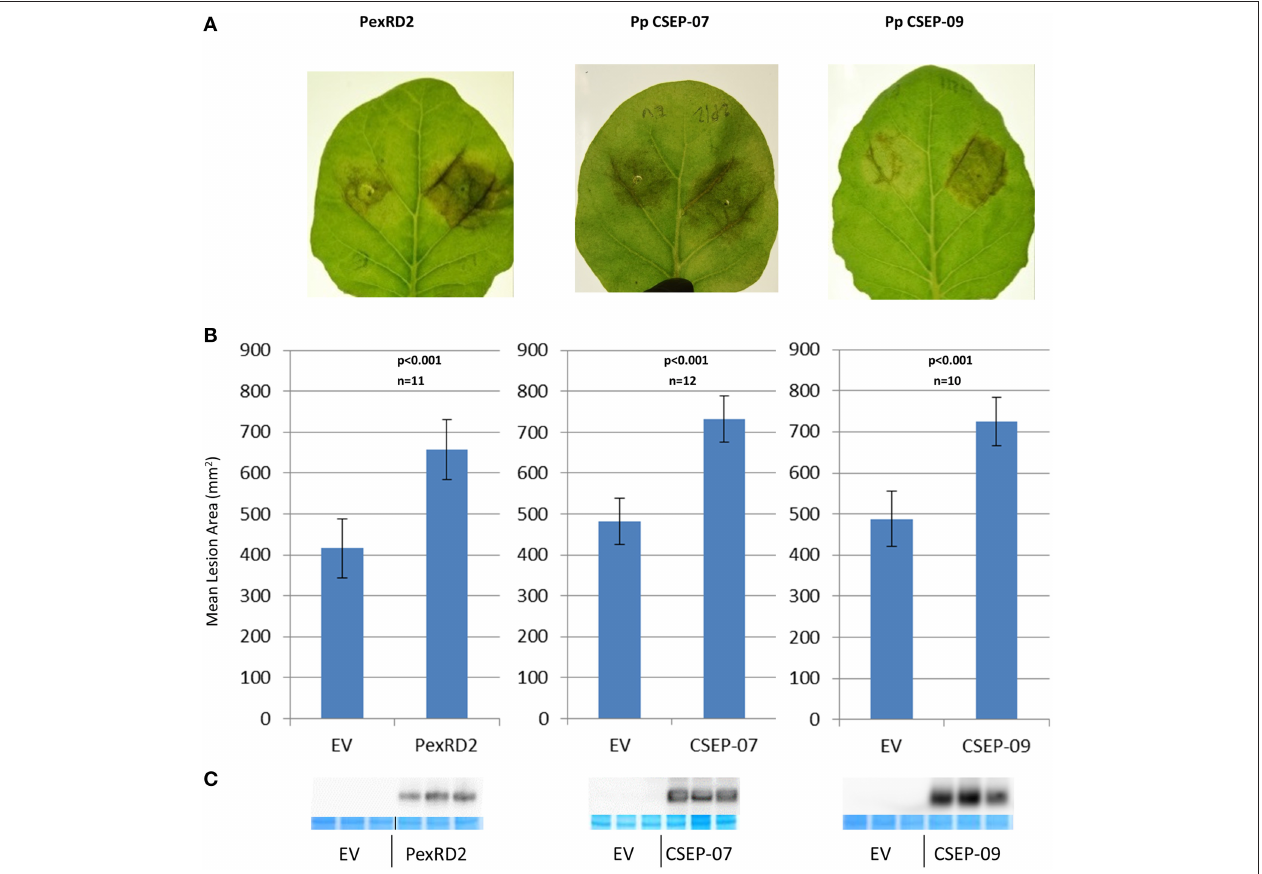
FIGURE 3 | Virulence phenotypes of P. pachyrhizi candidate effectors CSEP-07 and CSEP-09 (A) Representative leaves infiltrated agro-infiltrated with empty vector (left half of leaf) or indicated gene (right half of leaf), followed by inoculation with P. infestans zoospores. Images were taken at 7 days after zoospore inoculation. (B) Quantification of P. infestans lesion area 7 days after inoculation. P -value is from a two-tailed paired Student’s t -test. Results are an average of at least 10 inoculated leaves. (C) Immunoblot showing expression of indicated proteins from three plants that were agro-infiltrated but not inoculated with P. infestans . For each CE, protein was extracted from three independently infiltrated plants and immunoblotted with α -FLAG antibody. Directly below, protein from the same extraction was also loaded on a second gel and stained to demonstrate equal loading. This experiment was repeated twice with similar results.